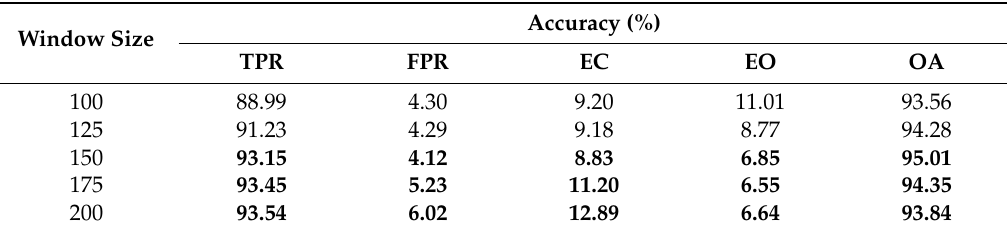
Table 4. Performance evaluation of wadi extraction results based on different window sizes. Window